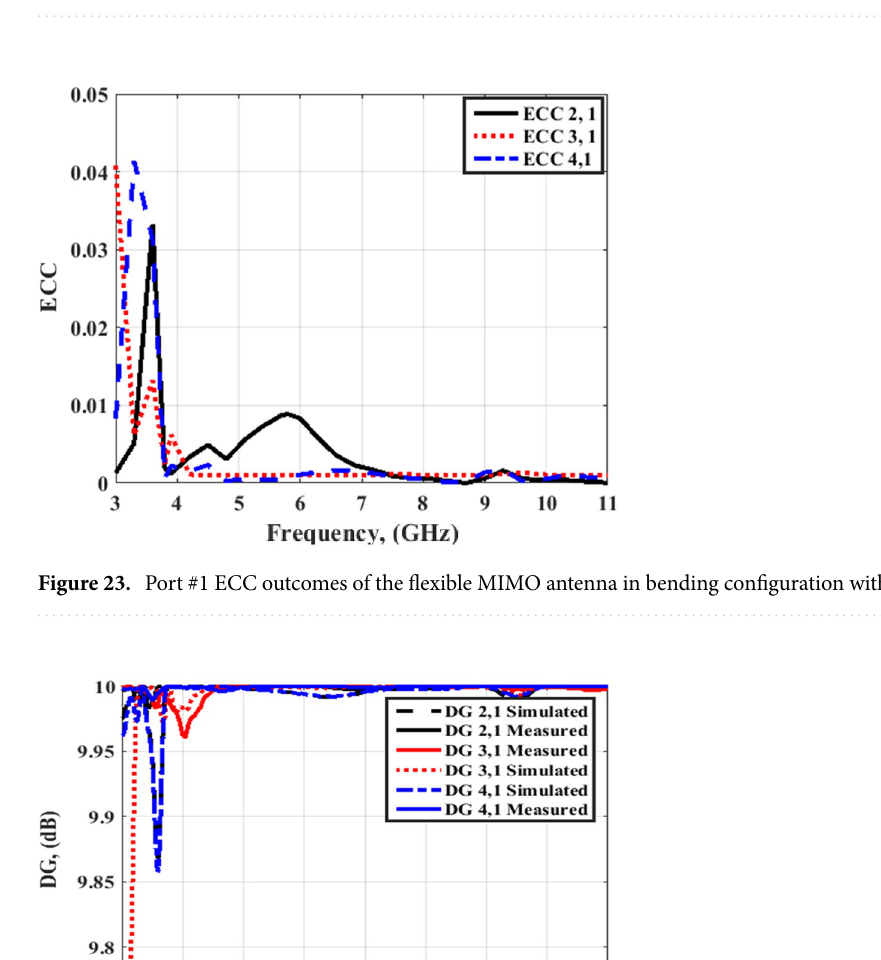
Figure 22. Port #1 ECC outcomes of the flexible MIMO antenna in the flat configuration.